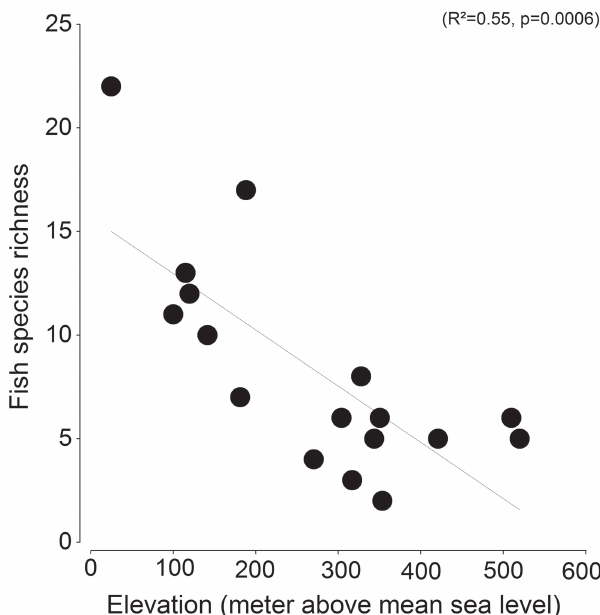
Fig. 2. Relationships between elevation and fish species richness in 17 sampling sites in the Río Acahuapa, San Vicente, El Salvador, 2011-2012.